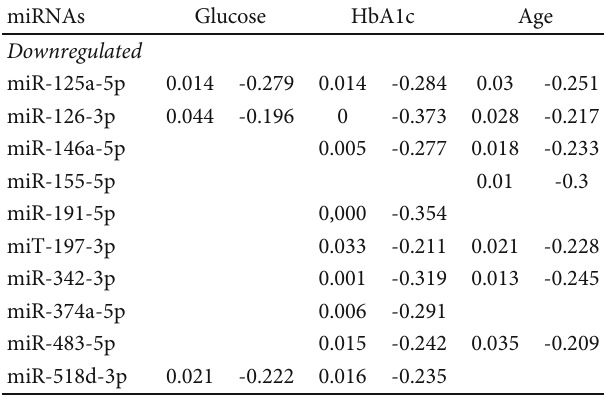
Table 6: Correlations of downregulated miRNAs from cluster B. miRNAs Glucose